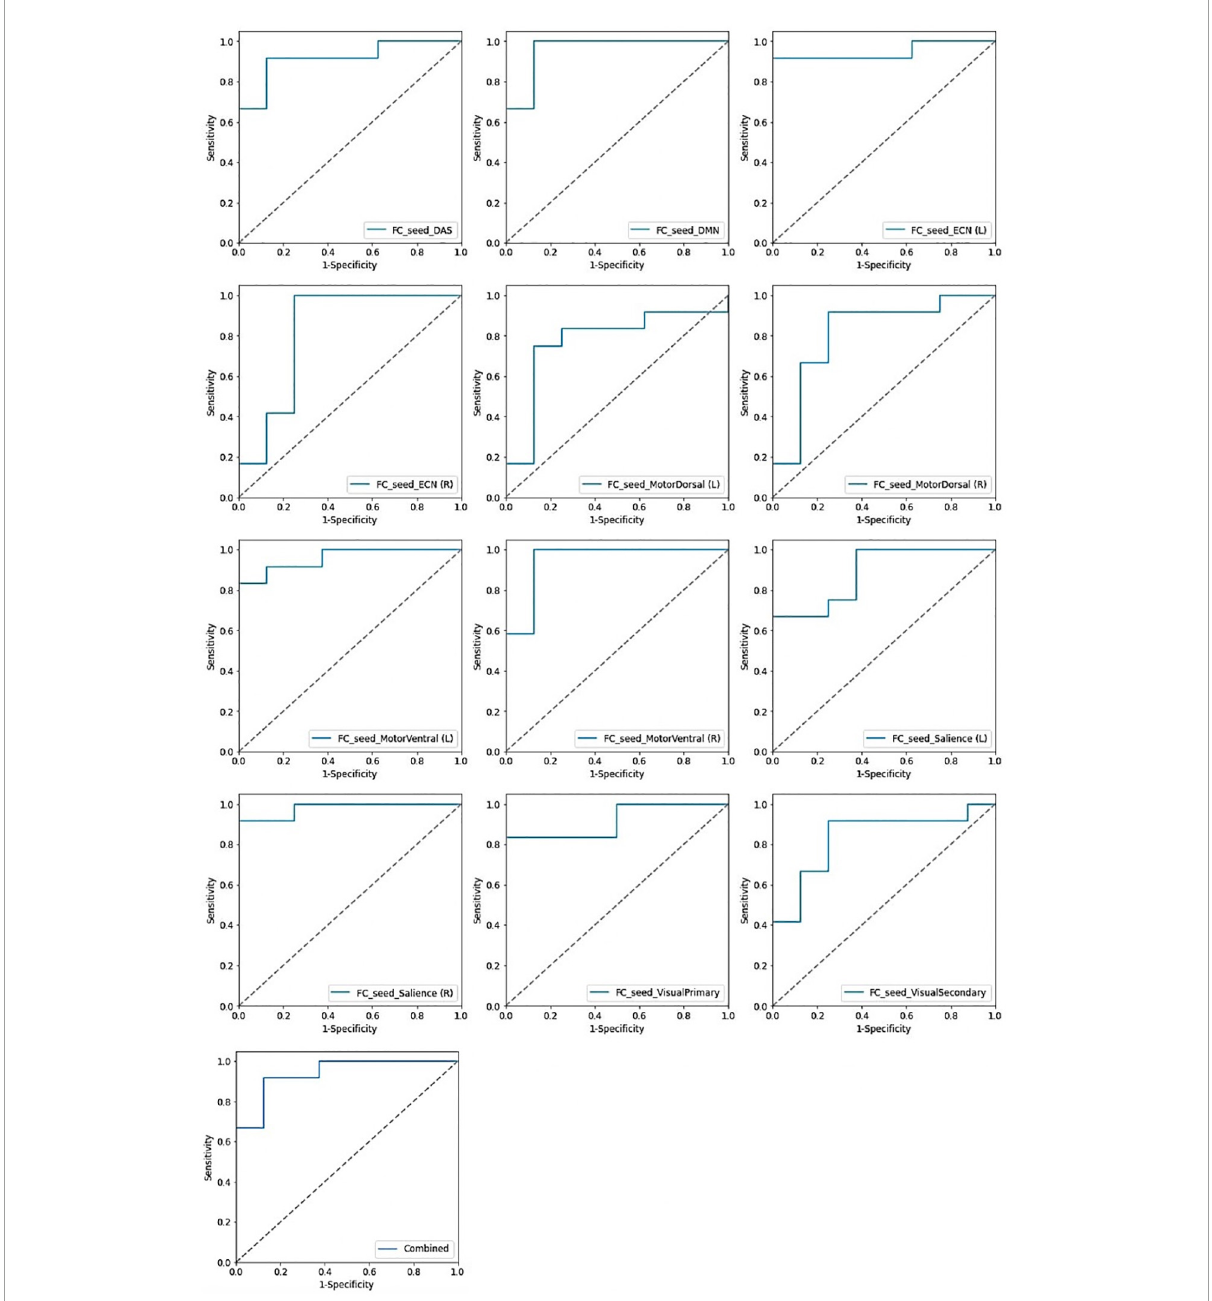
FIGURE5 Receiving operating characteristic curve (ROC) of the support vector machine (SVM) model based on the single and combined network